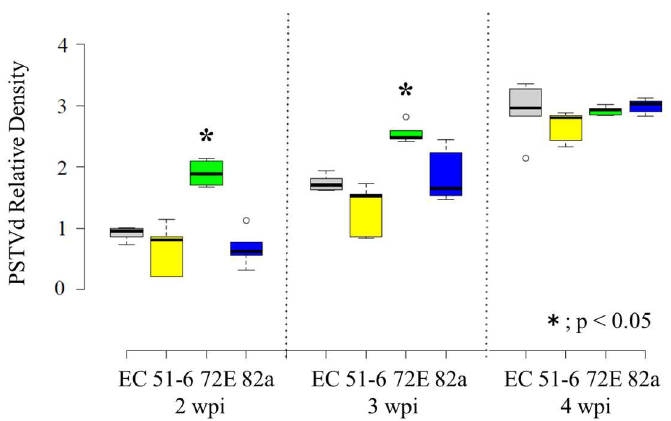
Figure 3. The relative density of PSTVd in three lines of the DCL2 / 4i Moneymaker tomato and the empty cassette control line at 2, 3, and 4 wpi. Five replicates of PSTVd-positive signals obtained by Northern-blot hybridization were quantified by ChemiDoc XRS, normalized using the gel image stained with ethidium bromide, and the averages were plotted on the graph. The thin vertical lines on the top indicate the error bar. The average value of the empty line at 2 wpi was adjusted as 1.0. The value in line 72E at 2 and 3 wpi with asterisks (*) were statistically significant at 5% level ( p < 0.05). Boxplots were drawn in BoxplotR [69] using the Tukey whisker extent. Center lines show the medians; box limits indicate the 25th and 75th percentiles as determined by R software; whiskers extend to 1.5-times the interquartile range from the 25th and 75th percentiles, and outliers are represented by dots. n = 3 sample points.